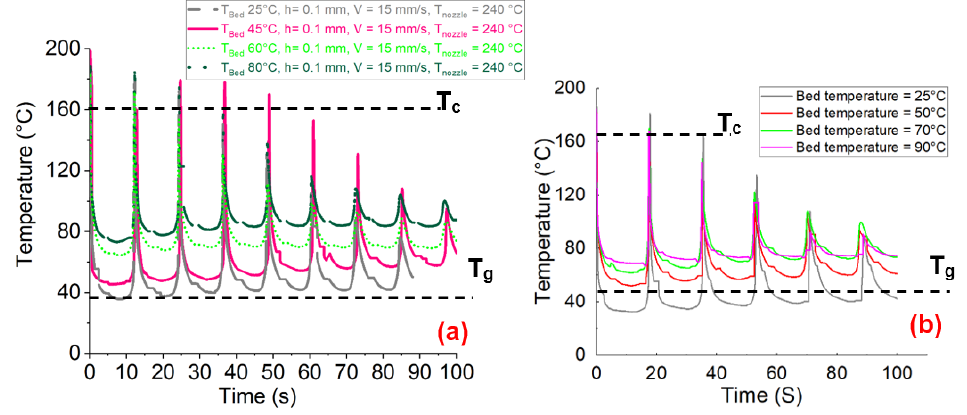
Figure 8. Monitoring of the temperature evolution during the FFF process concerning the different selected bed temperature values: ( a ) CF-PA6, ( b ) PA6.